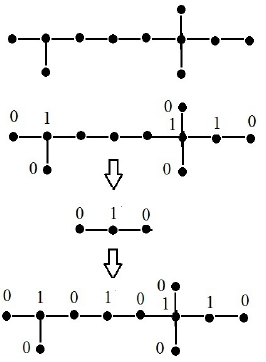
Figure 10. Finding a point in the core.